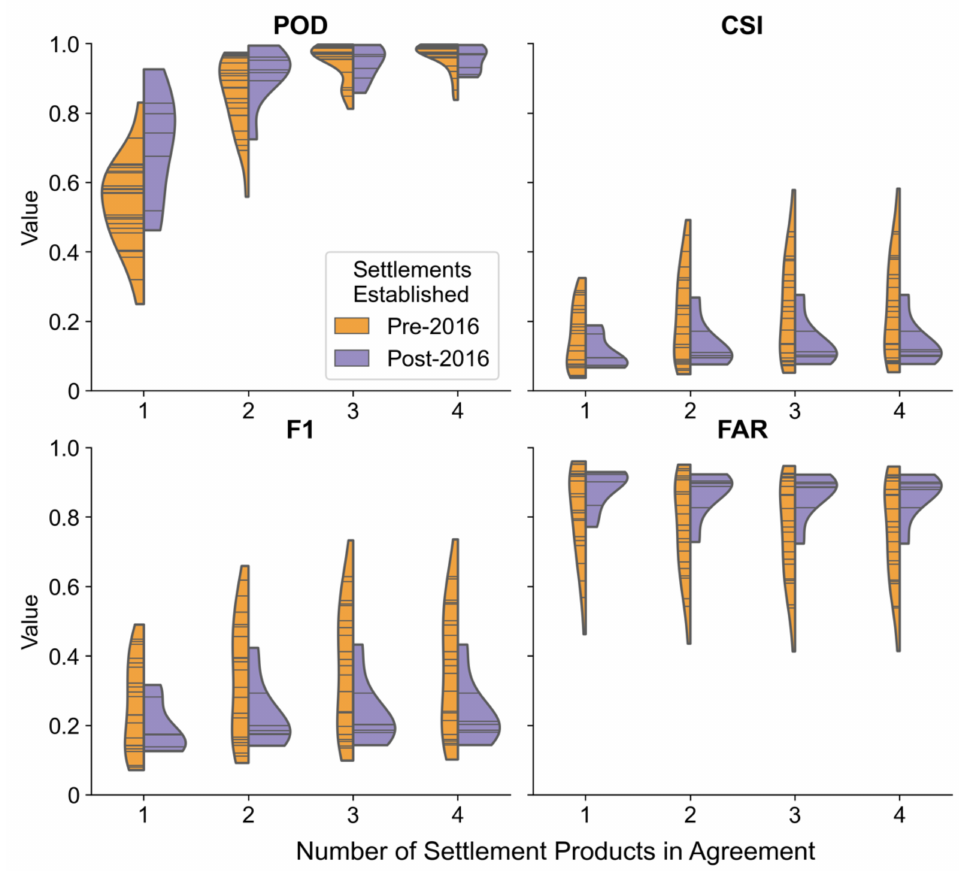
Figure 13. Violin plots of detection metrics, probability of detection (POD), critical success index (CSI), F1-score (F1) and false alarm rate (FAR) for multi-product agreement sites in comparison to OSM–MS building footprint coverage in settlements established before and in or after 2016: “1 product” indicates unique coverage by a single product; “2 products”, “3 products” and “4 products” indicate the number of settlement products that share coverage. Black horizontal lines in violin plots represent individual settlement observations. POD, probability of detection; CSI, critical success index; F1, F1-score; FAR, false alarm